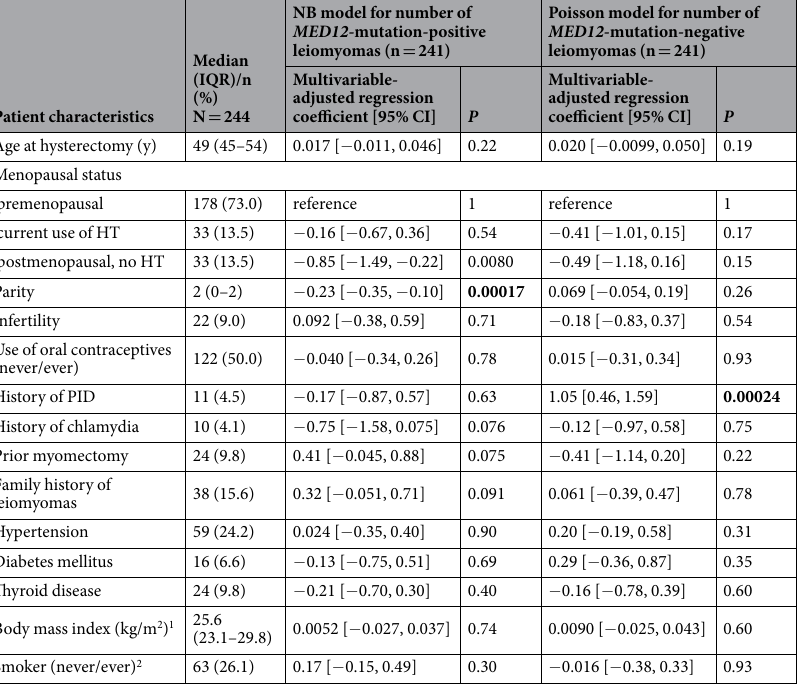
Table 3. Characteristics of uterine leiomyoma patients and results from negative binomial and Poisson models for MED12 -mutation-positive and –negative leiomyomas, respectively. To adjust for multiple comparisons, P < 0.00147 indicated statistical significance (the Bonferroni correction). CI = confidence interval; IQR = inter quartile range; HT = hormone therapy; NB = negative binomial; PID = pelvic inflammatory disease. 1 One value missing. 2 Three values